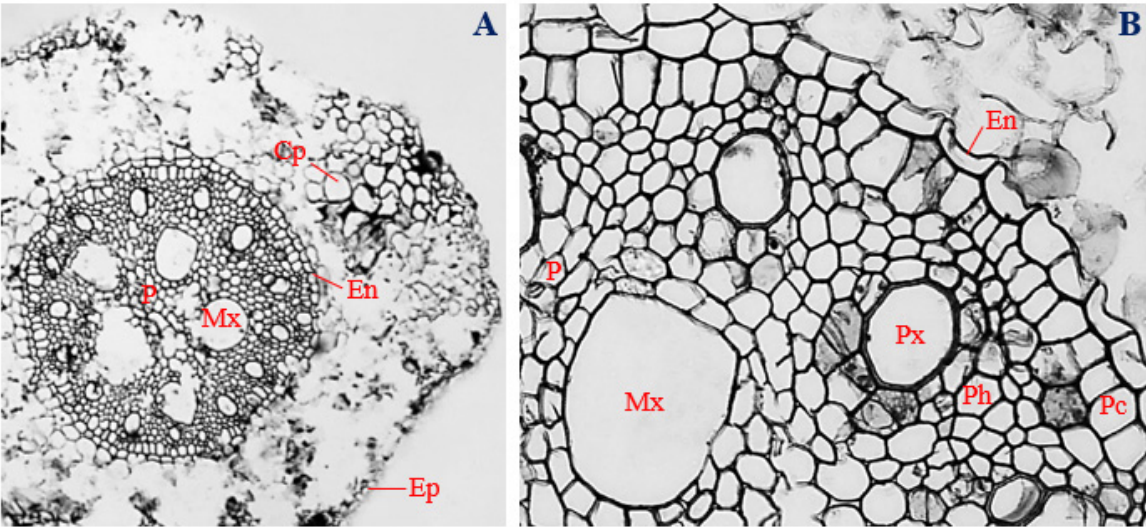
Figure 4. The transverse section of corn roots infected with endophytic Penicillium citrinum . ( A ) Magnification 40×; ( B ) magnification 200×. Ep, epidermis; Cp, cortical parenchyma; En, Endodermis; Pc, pericycle; Px, protoxylem; Ph, phloem; Mx, metaxylem; and P, pith.